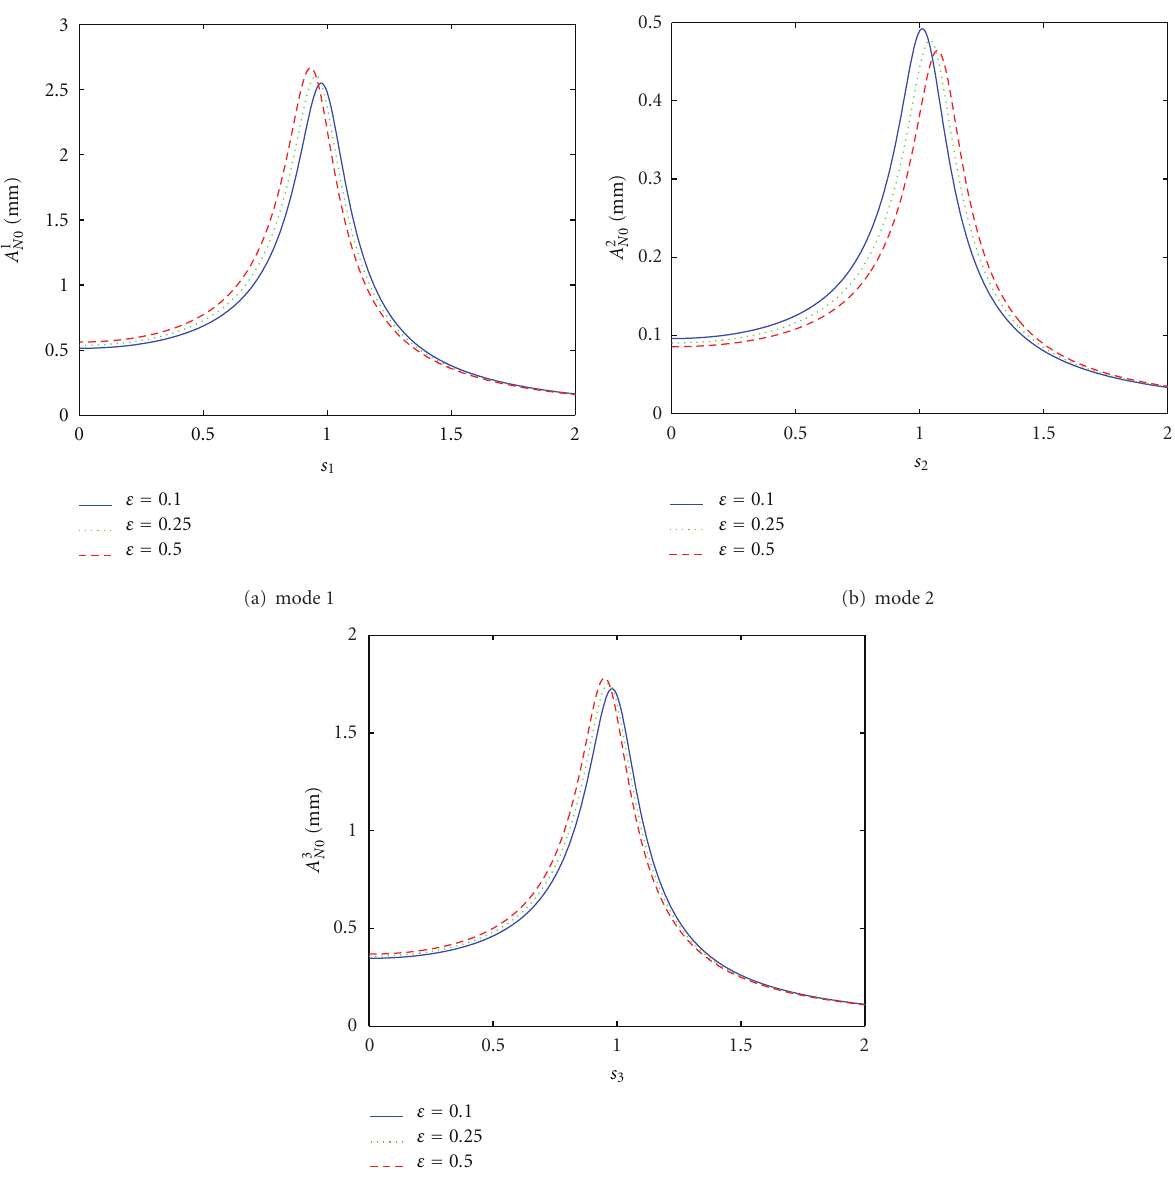
Figure 5: Nonlinear forced vibration to coupled excitations near natural frequencies.